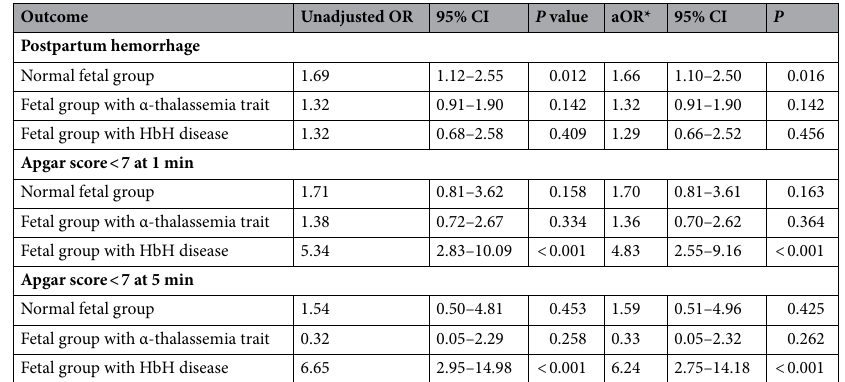
Table 4. Unconditional binary logistic regression analysis of pregnancy outcomes with women without thalassemia as the reference group. *Adjusted for maternal age, gravidity, parity, ethnic group, gestational weeks at first visit, number of prenatal visits, residency in Guangxi province or fetal sex.